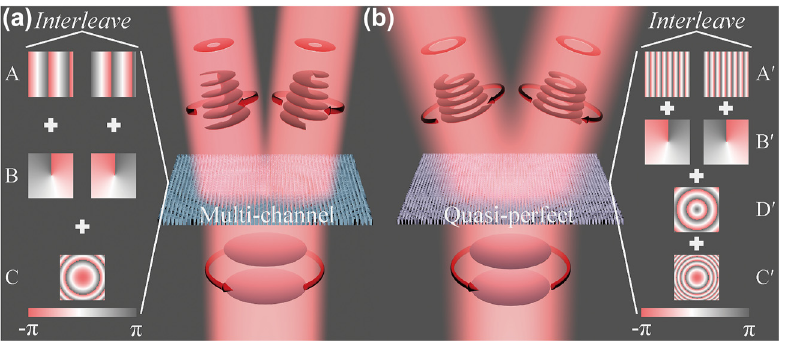
Figure 1: Multi-channel (a) and quasi-perfect (b) vortex beams generation based on all-dielectric synthetic-phase metasurfaces. The phase distribution of metasurfaces A(A ′ ), B(B ′ ) and C(C ′ ) correspond to beam deflection, OAM mode conversion and beam focusing (from up to down). The metasurface D ′ in the inset of this figure is designed to replace the negative axicon. The red arrows represent left circular polarization (anticlockwise) and right circular polarization (clockwise). The circular and spiral plane denotes the plane and spiral phase fronts of terahertz